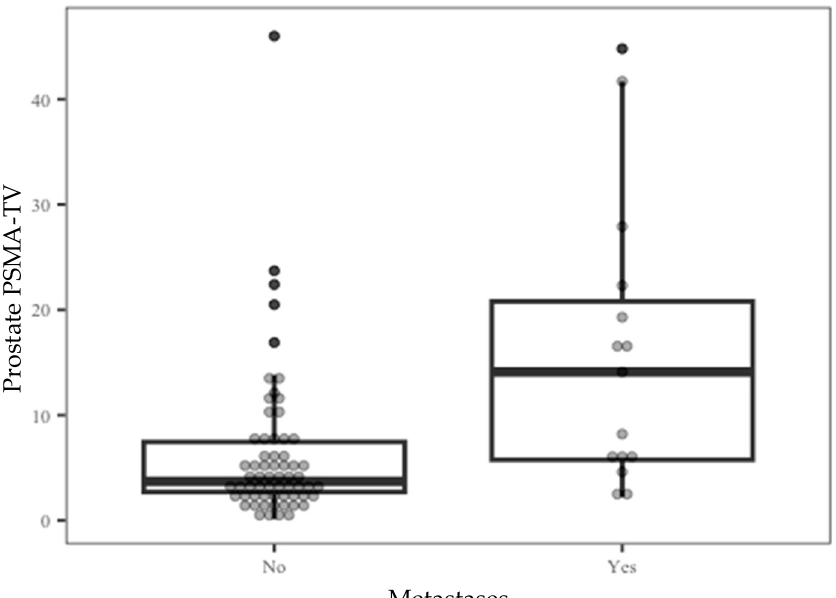
Figure 1. Prostate PSMA ‐ TV distribution by the metastatic outcome.